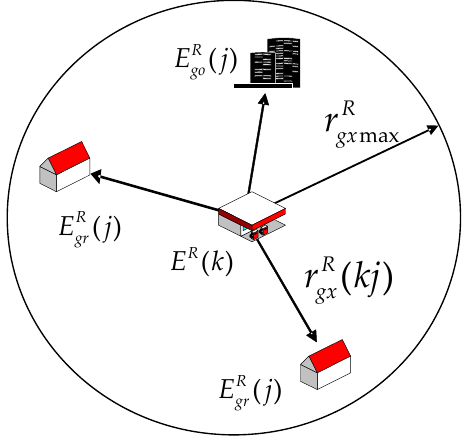
Figure 3. The transfer of REEQ from gas stations to DCIs in office areas and residential areas.